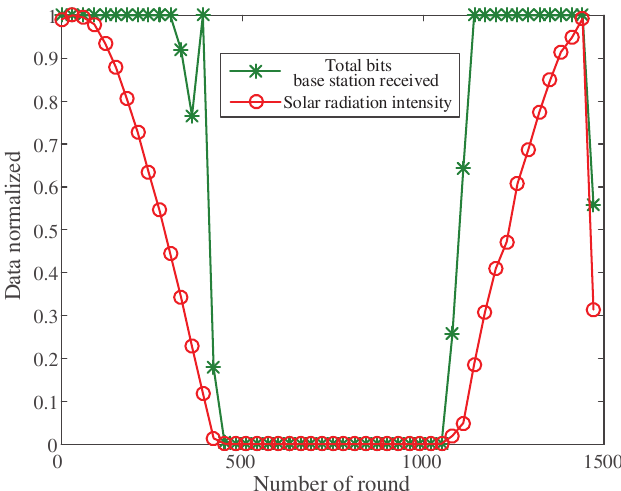
Figure 7. The curve of the solar radiation intensity and the sum of the number of image bits received by the base station.